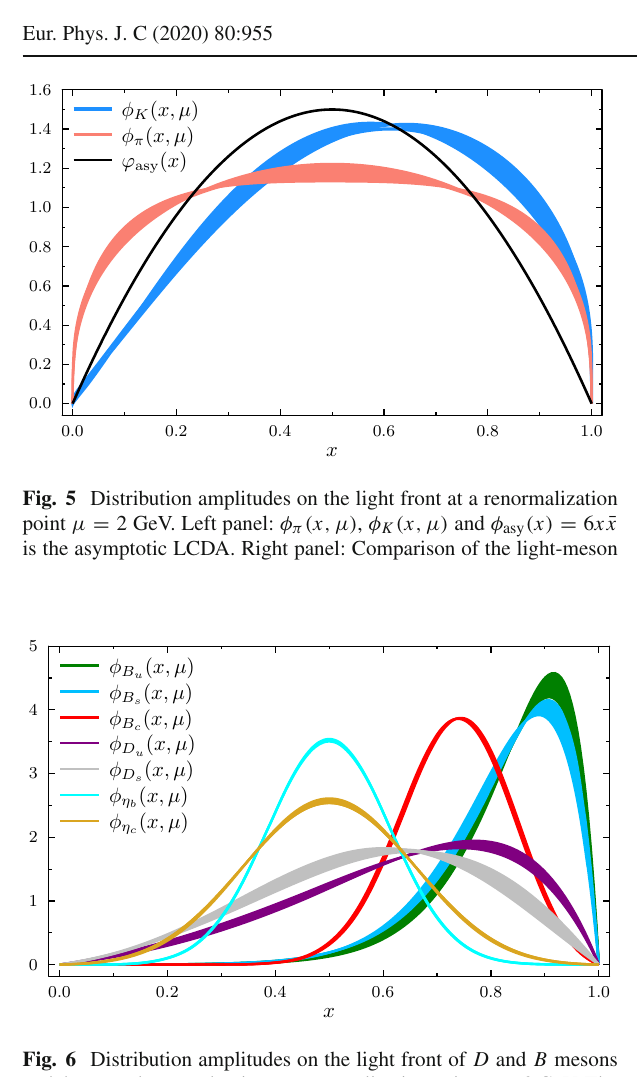
Fig. 6 Distribution amplitudes on the light front of D and B mesons and the η c and η b quarkonia at a renormalization point μ = 2 GeV. The error bands correspond to a variation of ω f ± Δω f in the interaction